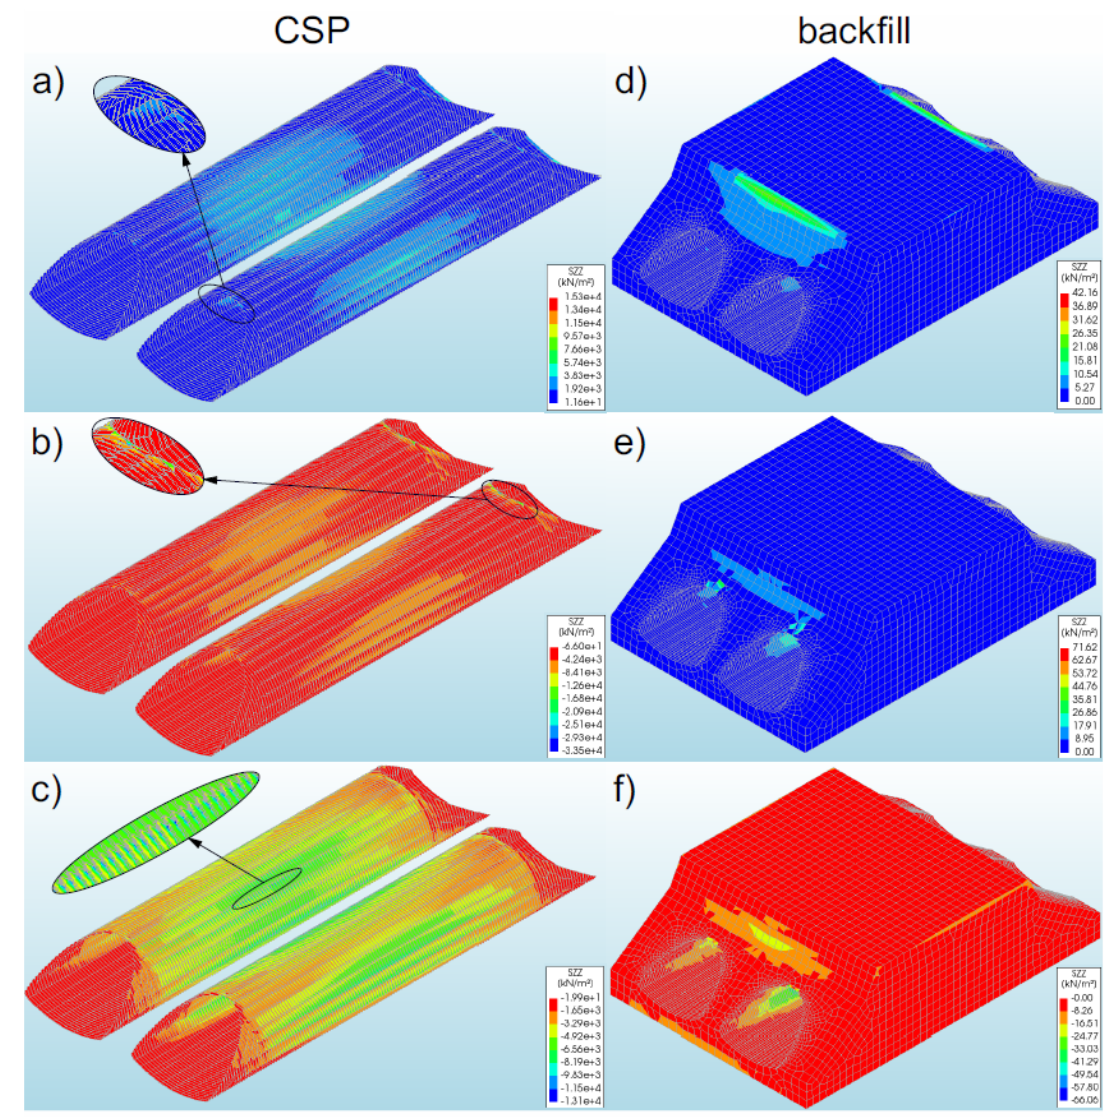
Figure 15. View of the maximum global stresses (in Z direction) for bridge #II in the steel shell and backfill for model 4 ( a , d ), model 5 ( b , e ), and model 6 ( c , f ).